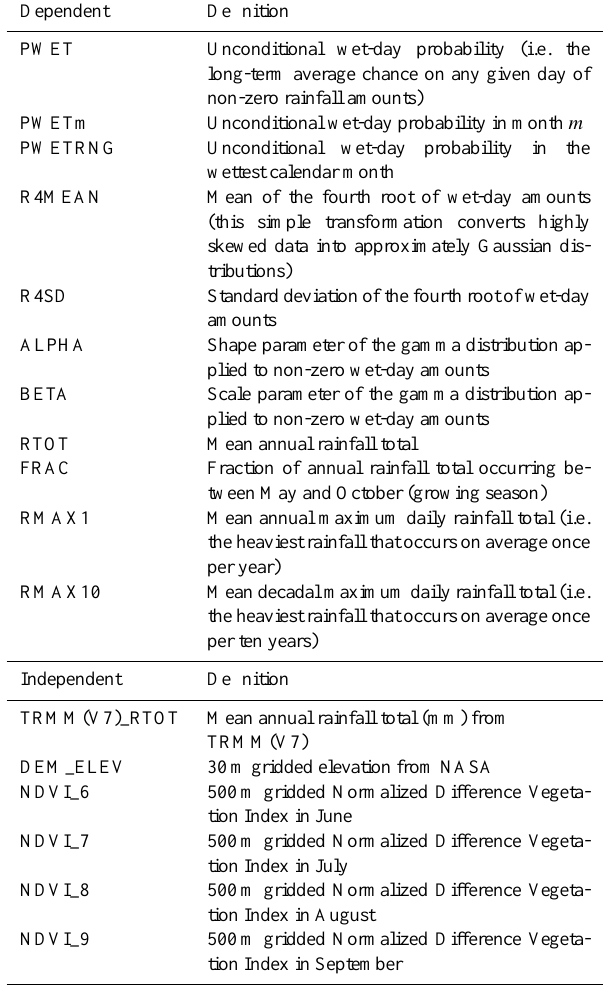
Table 1. Dependent and independent variables used to estimate lo- cal